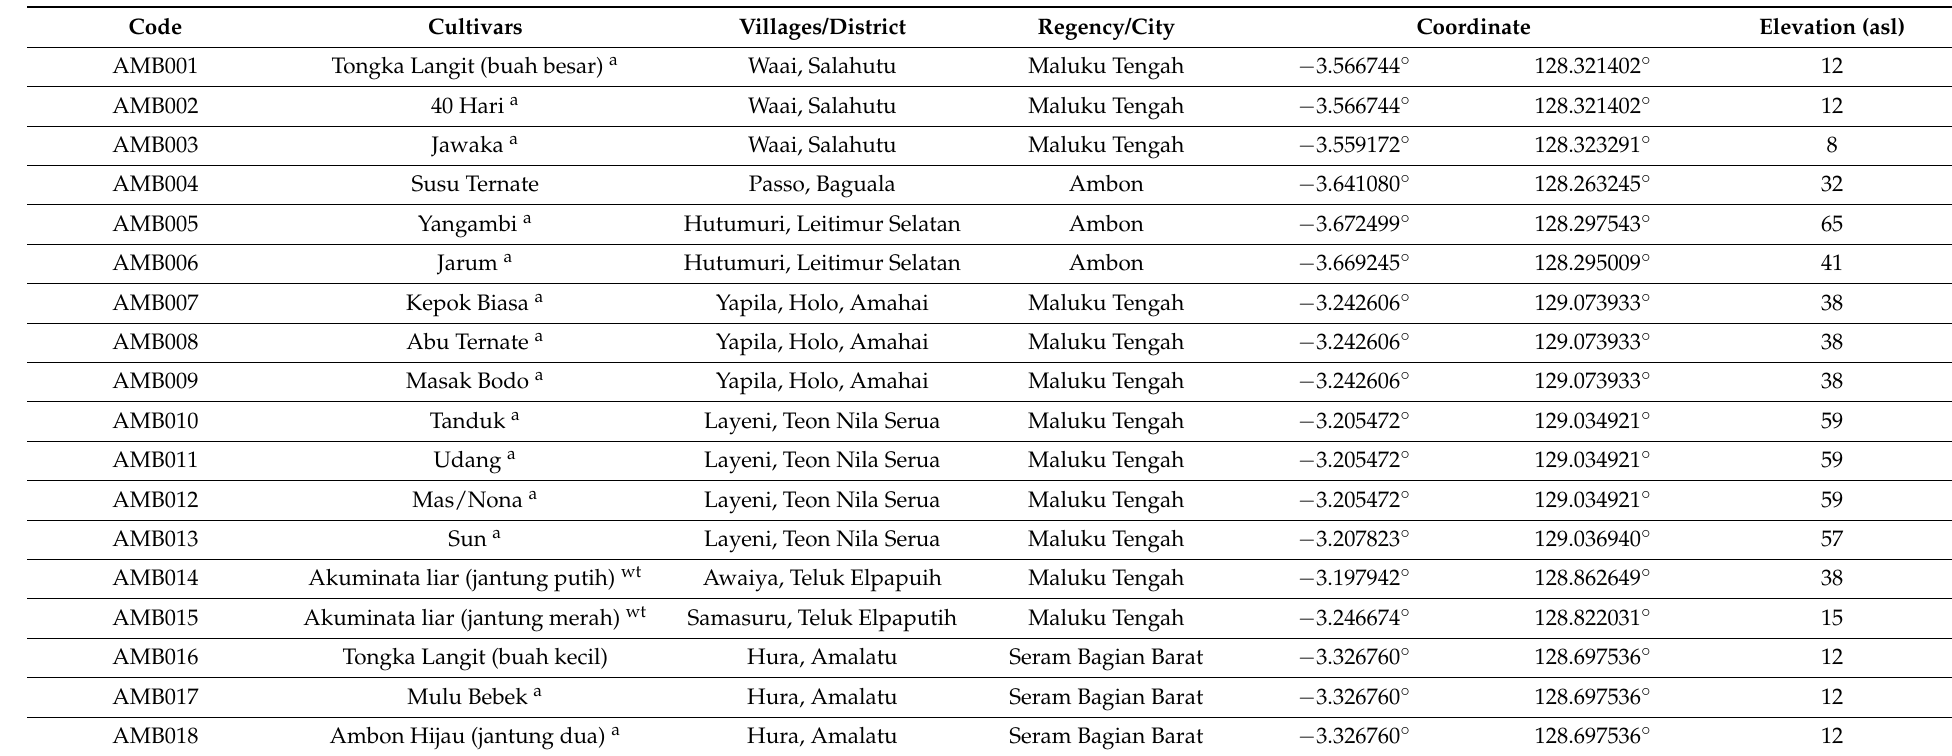
Table 4. The richness of banana cultivars in